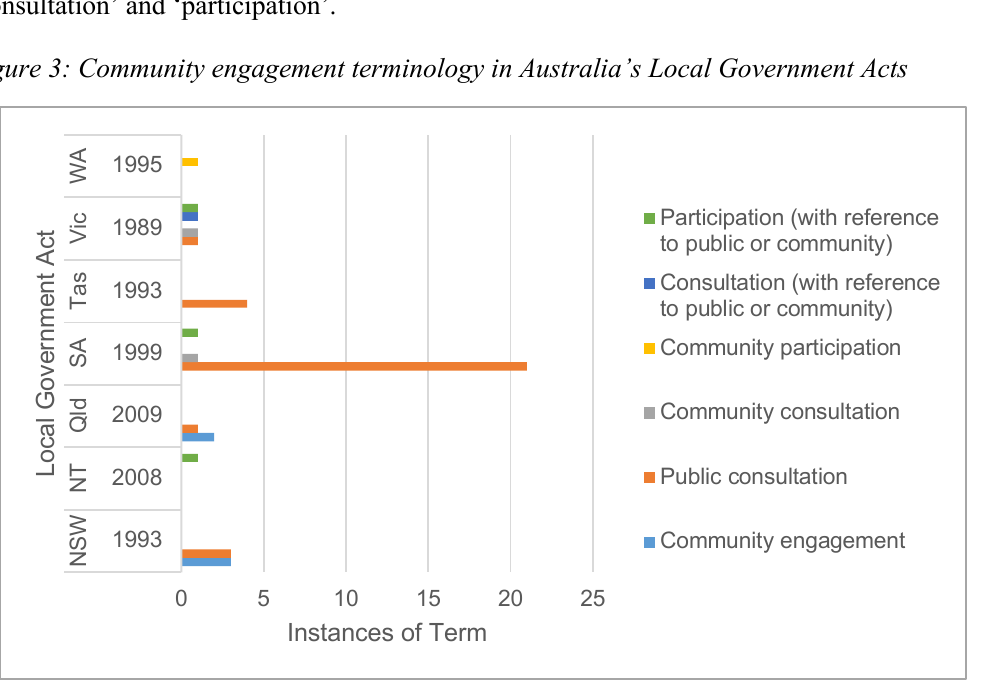
Source: Local Government